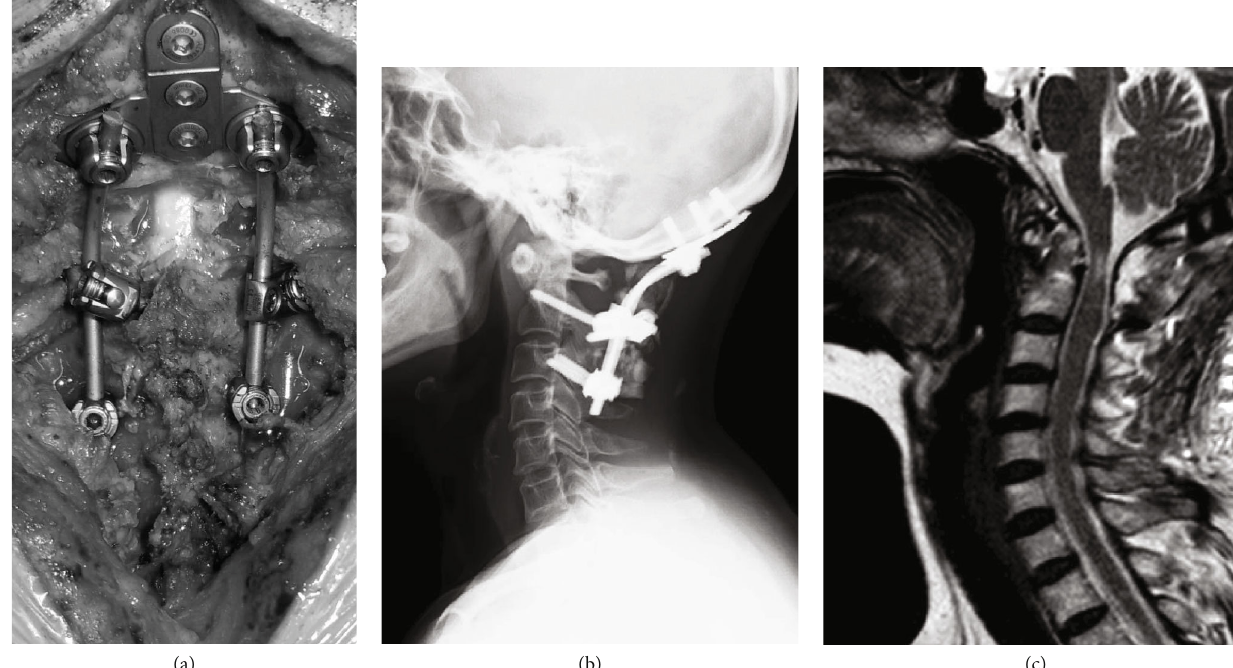
Figure 2: Postoperative image. Posterior decompression fusion from the occipital bone to C3 was performed (a). Side view X-rays show successful placement of the implant as indicated (b). MRI reveals that the compression of the spinal cord has been released by C1 laminectomy